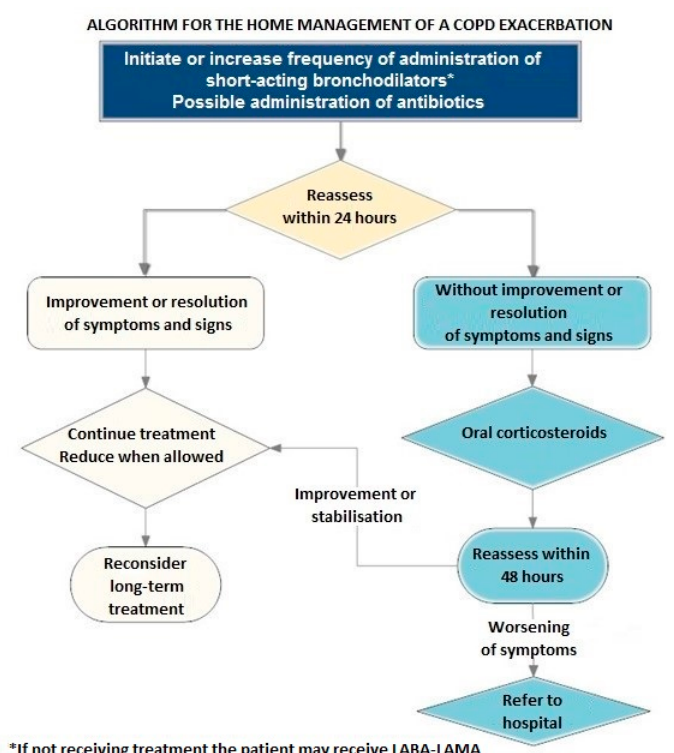
Figure 3. Home management of a COPD exacerbation. Abbreviation: COPD, chronic pulmonary disease.